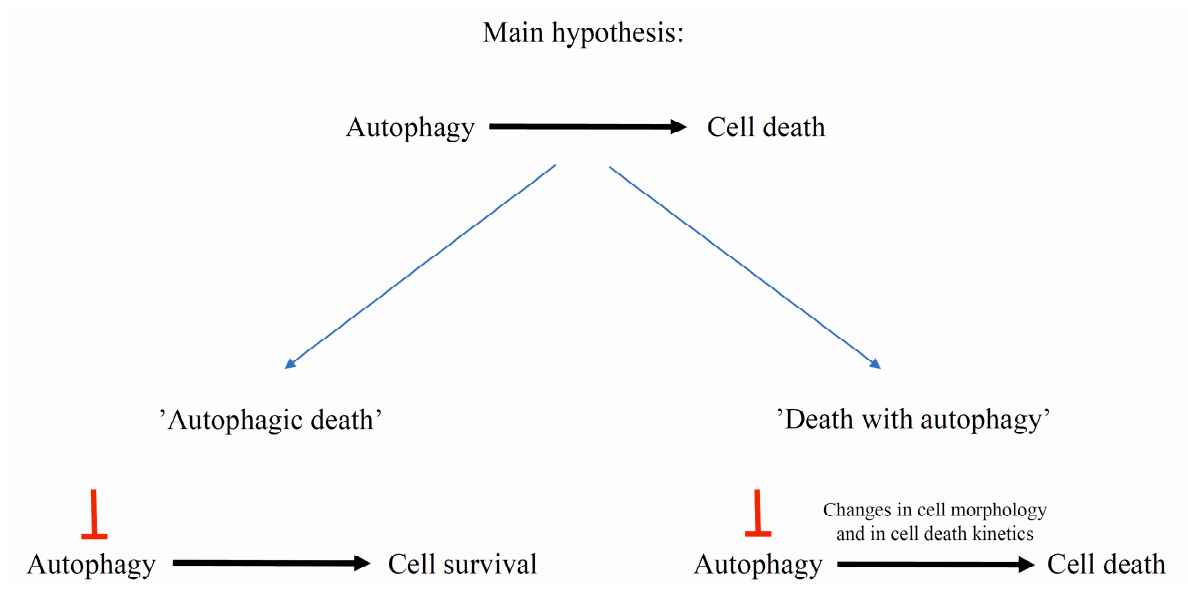
Figure 2. To determine whether autophagy acts in a cell pro-death or pro-survival manner, an experimental approach based on inhibition of autophagy is needed. “Autophagic death” occurs when inhibition of autophagy contributes to cell survival, whereas “death with autophagy” occurs when inhibition of autophagy, for example, delays cell death, but finally it will occur.